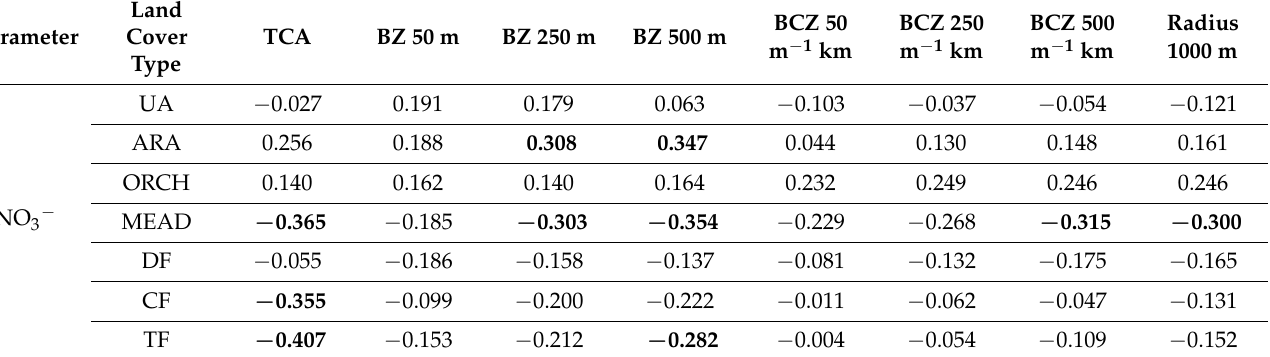
Table 2. Spearman rank correlation coefficients linking selected land cover metrics from Corine Land Cover 2018 and mean NO 3 − , NO 2 − , NH 4+ , EC across investigated lowland streams during the